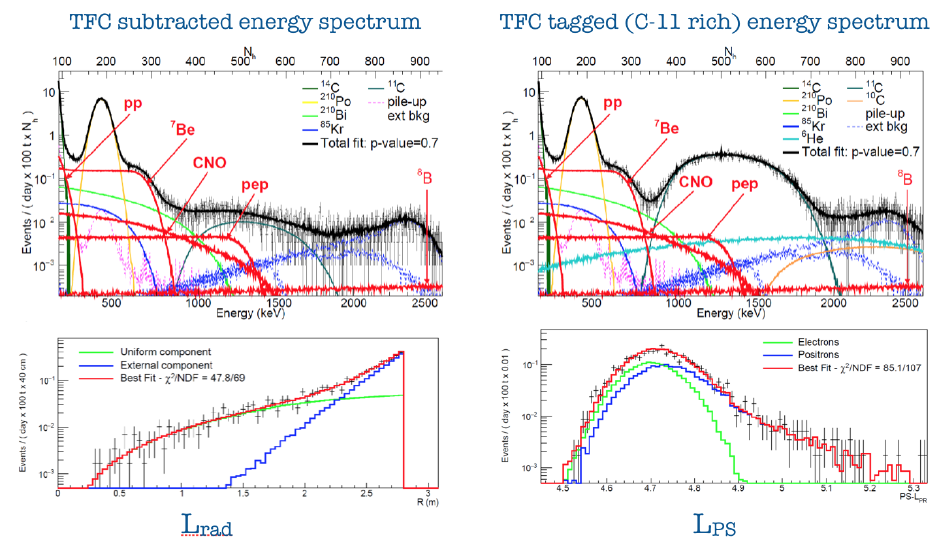
Figure 4: Illustration of the Phase II Borexino fitting strategy used to simultaneously determine the interaction rate of pp , 7 Be, and pep solar neutrinos. The fit also returns an upper limit for CNO neutrinos, as well as rates for all relevant background